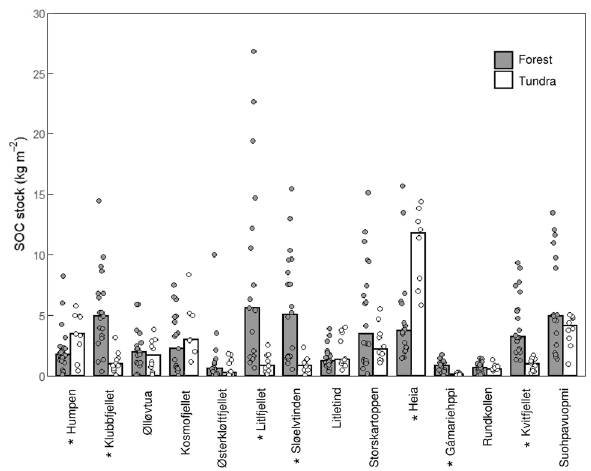
Figure 3. Soil organic carbon (SOC) stocks in surface soils in treeline forests and in tundra above the treeline across 14 treeline ecotones in northern Norway. Bars show median values, datapoints show individual observations. Study sites are arranged from southernmost site (i.e., Humpen) to northernmost site (i.e., Suohpavuopmi). Study sites with statistically significant (Mann–Whitney U tests, p < 0.05) differences between SOC stocks in forest and tundra soils are indicated with an asterisk.